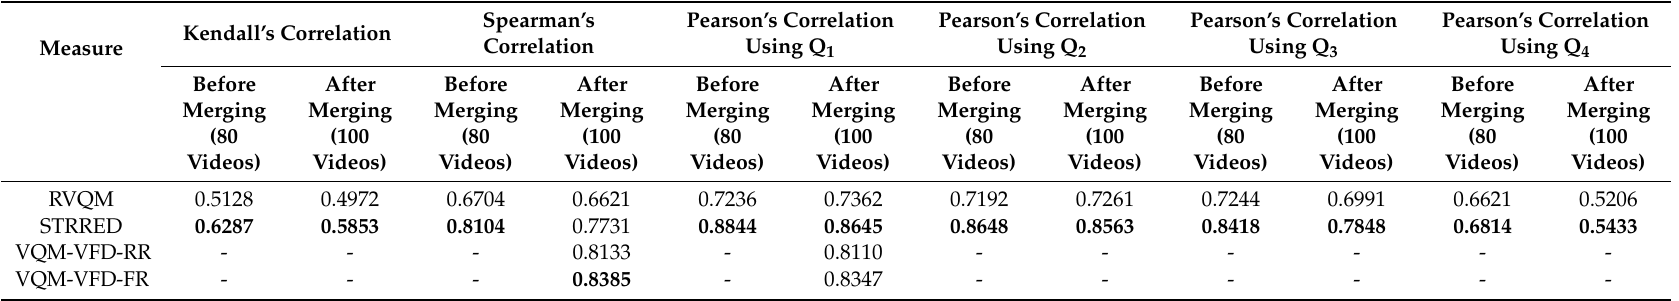
Table 11. Kendall’s, Spearman’s, and Pearson’s correlation, before and after combining RVQM and STRRED with freezing degradations; VQM-VFD-RR